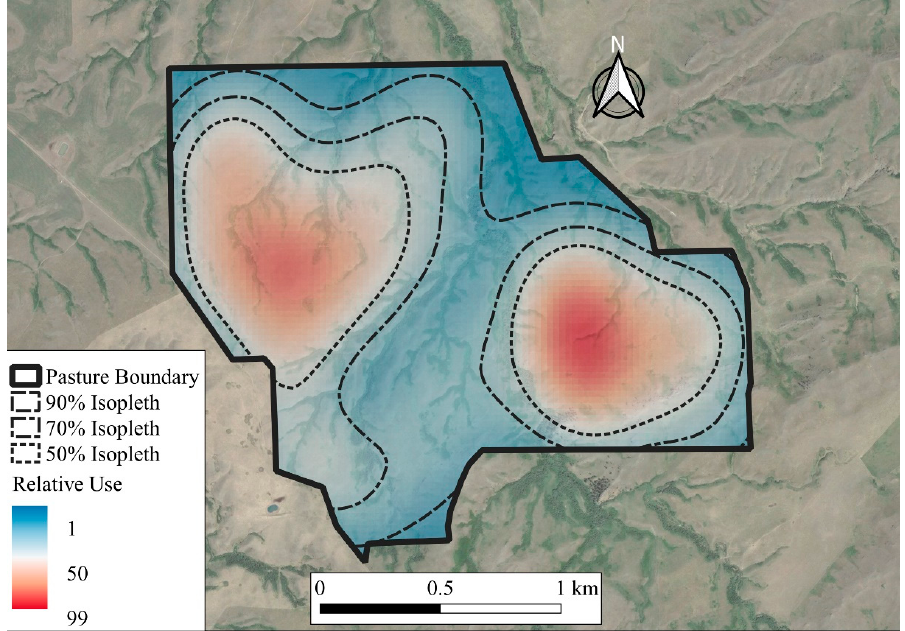
Figure 1. Isopleth showing relative use of one cow winter grazing dormant mixed-grass prairie at the Northern Agriculture Research Center’s Thackeray Ranch, Havre, MT, USA (45-day grazing period).